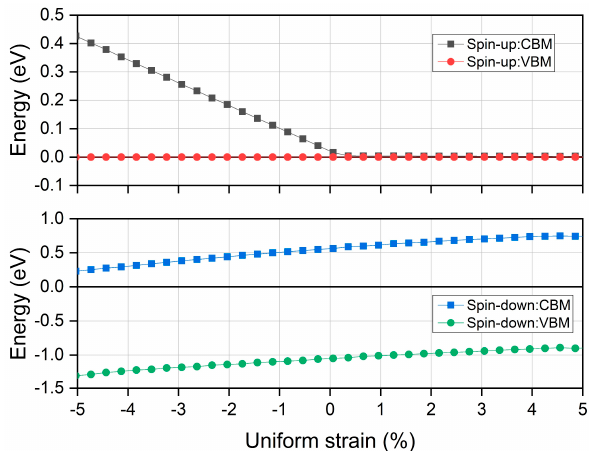
Figure 5. The calculated total and partial magnetic moments under different uniform strains for the half Heusler compound MnPK.